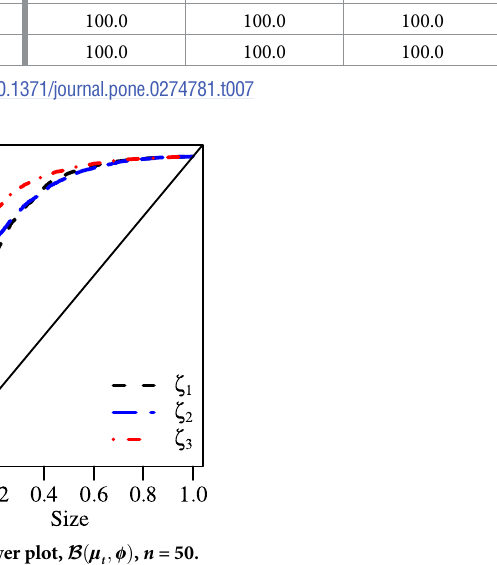
Fig 5. Size-power plot, B ð μ